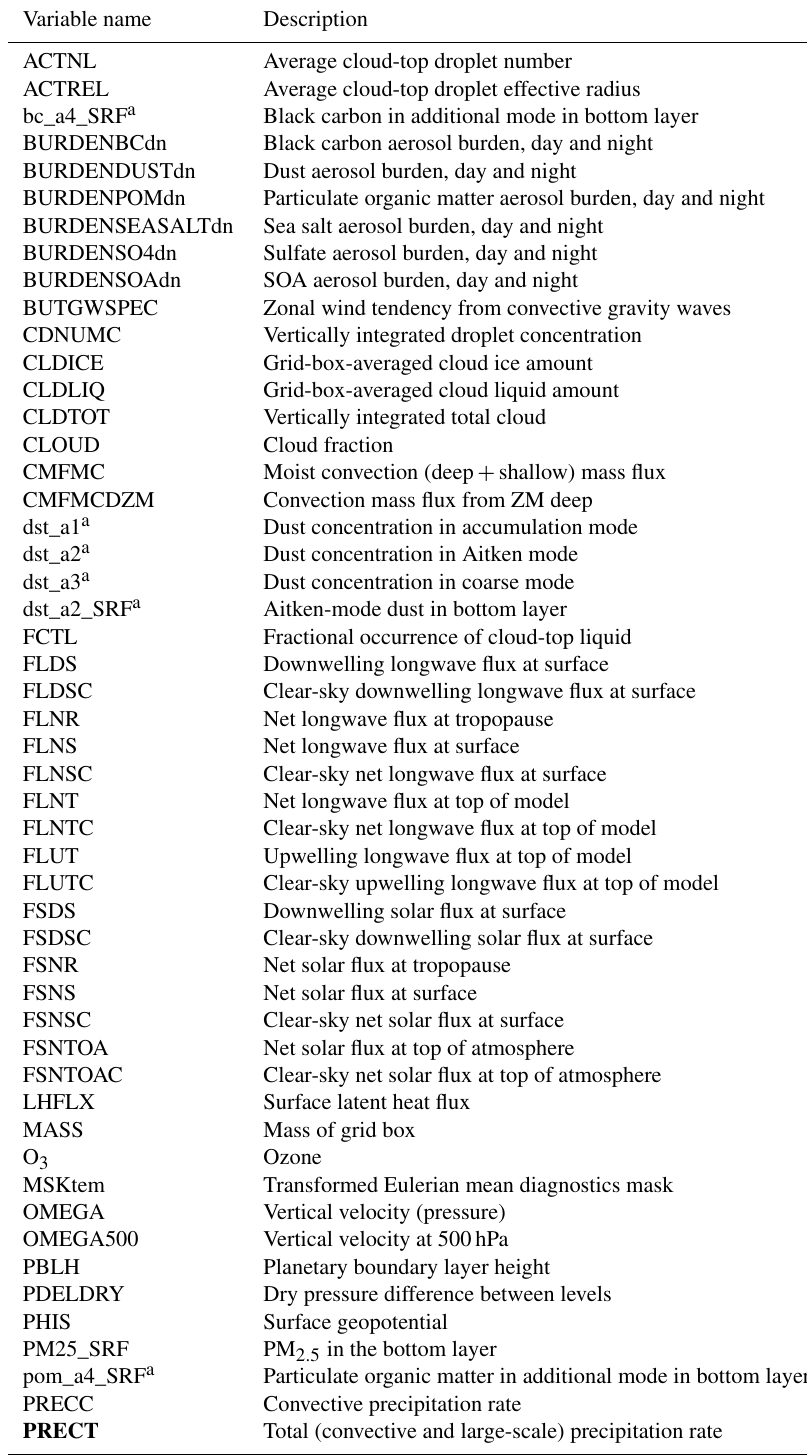
Table A2. Available daily averaged output from the atmospheric model in ARISE-SAI-1.5 simulations and SSP2–4.5 CESM2(WACCM6) simulations. a Variables not available from the first five members of CESM2(WACCM6) SSP2–4.5 simulations. b Variables that are available (but erroneous) in the first five members of CESM2(WACCM6) SSP2–4.5 simulations. Variables in bold are used to calculate indices of extremes such as those presented in Tye et al.